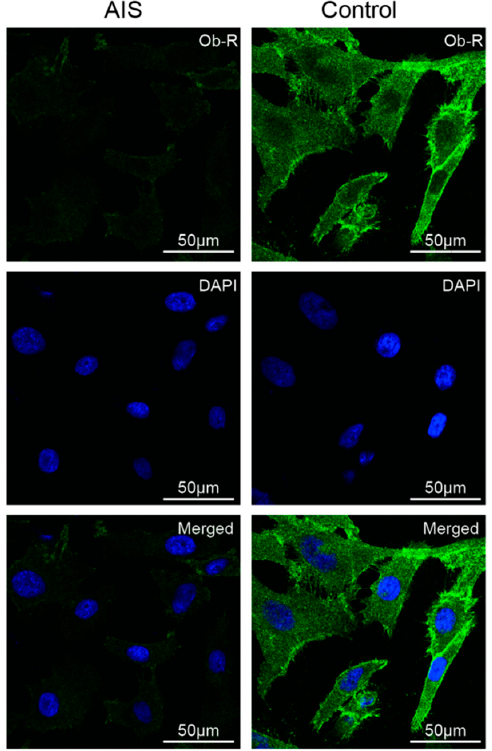
Figure 2. Immunofluorescence detection of Ob-R in primary chondrocytes isolated from the AIS and the control groups. Ob-R was labeled with green fluorescence, and the nuclei were stained with DAPI and shown as blue fluorescence. The AIS group is presented in the left column, and the control group is presented in the right column. Strong signals of Ob-R are present in the control group. Scale bars = 50 μ m.